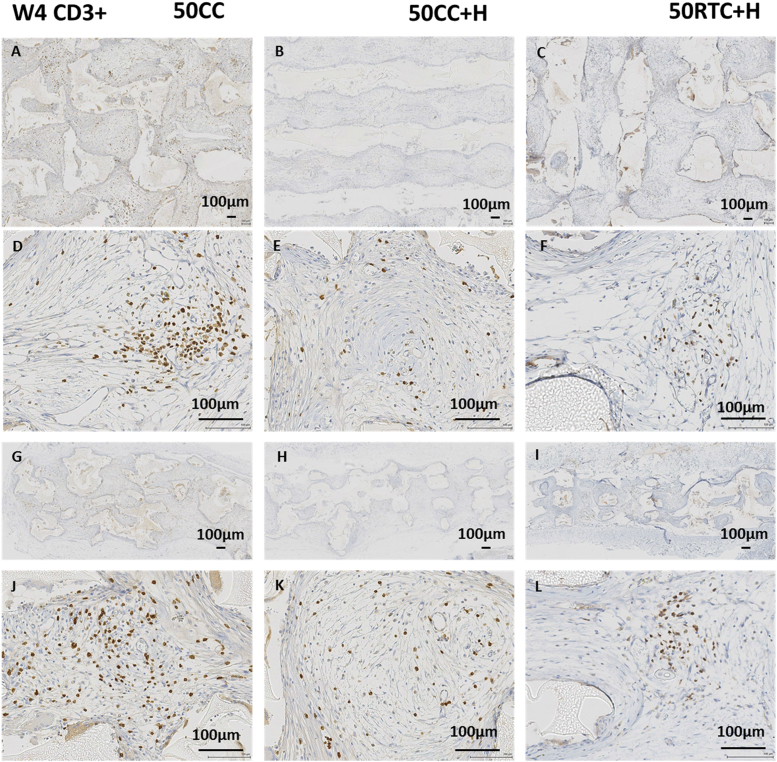
Immunohistochemistry of the host T lymphocyte response towards scaffolds in vivo at week 4. Tissue integration of middle-in-plane (A-F) and cross-sectional view (G-L) of the scaffolds by CD3 (T lymphocyte marker) staining at (A-C, G-L) ×4 and (D-F, J-L) ×40 magnifications.